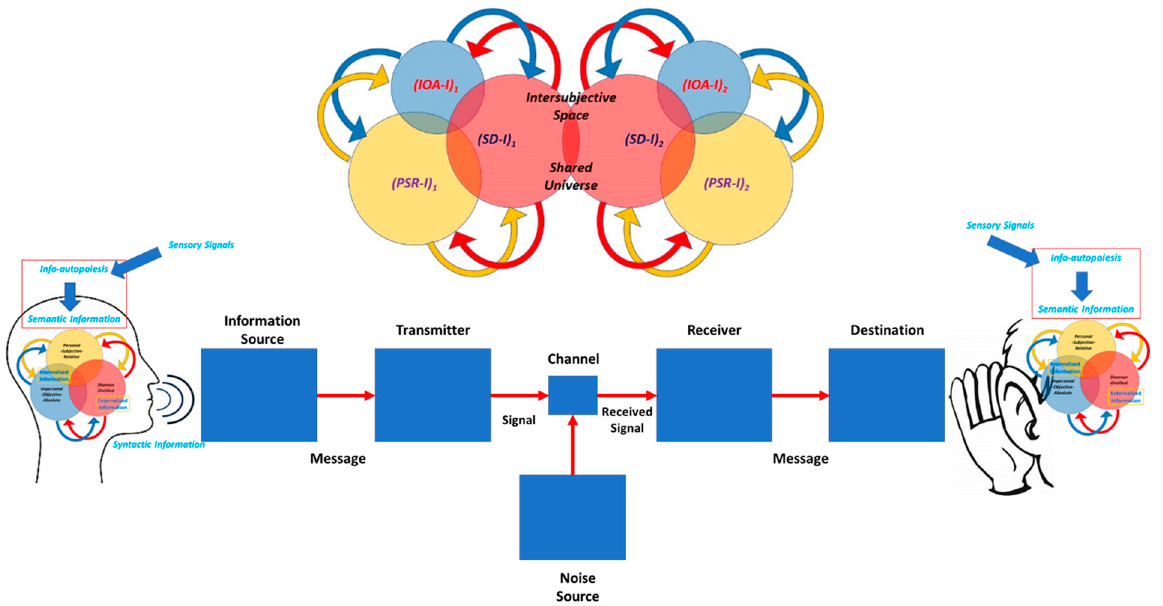
Figure 4. Info-autopoietic communication: sensory signals transform into semantic and syntactic information.